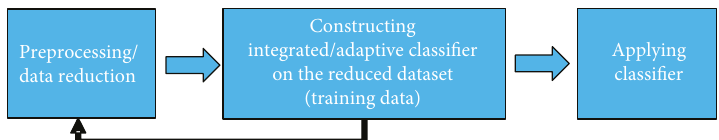
Figure 1: Integrated and adaptive learning from examples with data